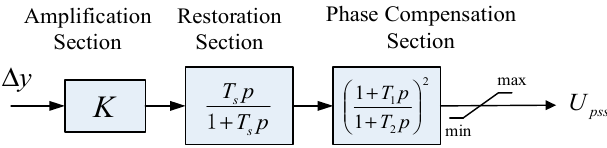
Figure 3. Diagram of the power system stabilizer (PSS) transfer function.